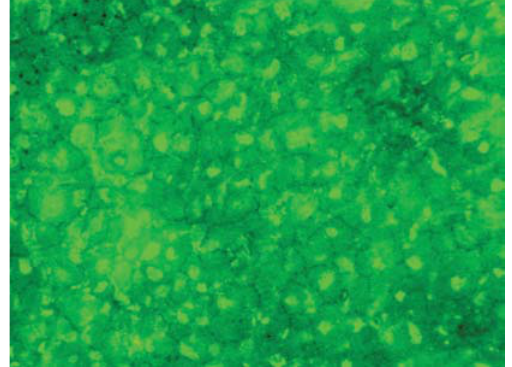
Figure 1 - A significant positive immunofluorescent staining for oxLDL in liver tissue sections of the prolonged jaundiced group of rats.